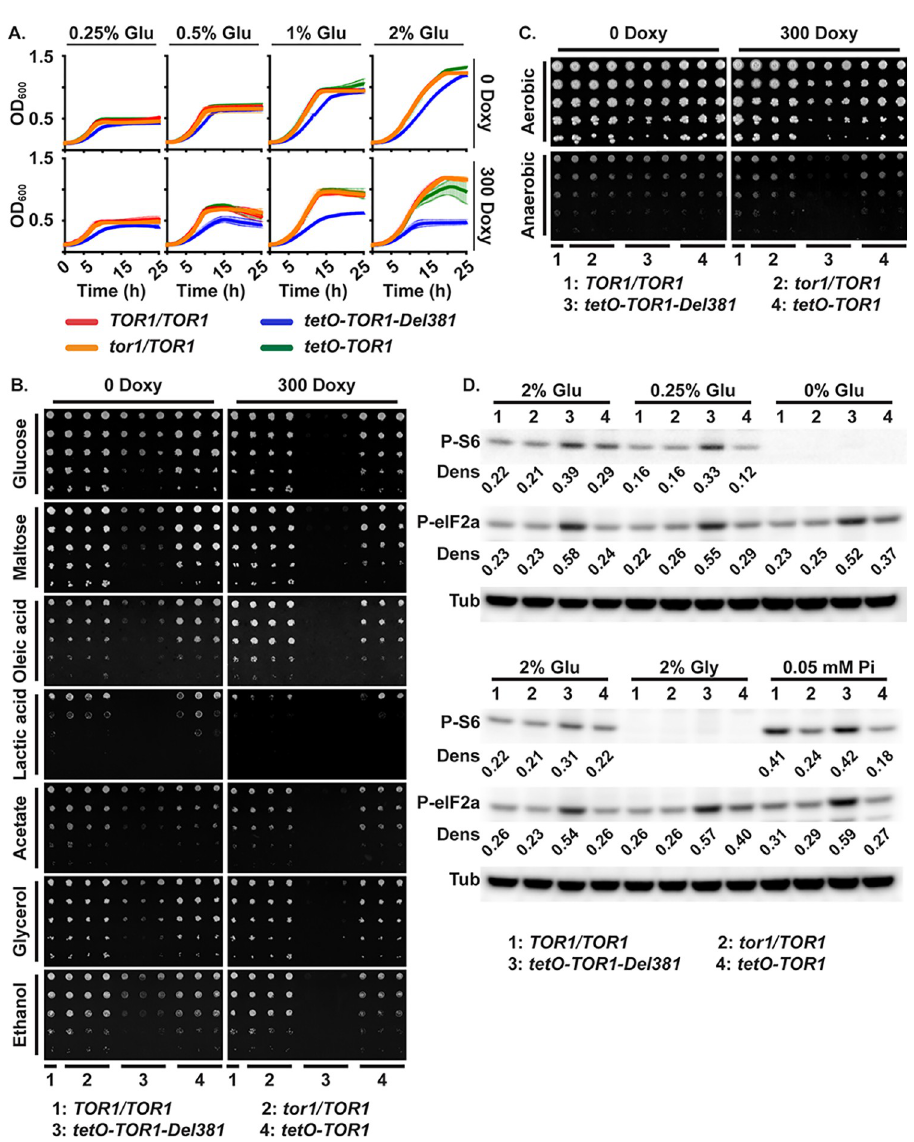
Fig 3. Cells lacking Tor1 N-terminal HEAT repeats failed to adapt growth to carbon source availability and were defective in growth on non-fermentable carbon sources. A. Cells were grown in YNB medium with varying concentration of glucose (Glu), without or with 300 ng/ml doxycycline (300 Doxy). B. Cells of indicated genotypes were spotted onto YNB without inositol agar medium containing different carbon sources (2% w/v), without or with 300 ng/ml doxycycline. ( TOR1/TOR1 , JKC1713; tor1/TOR1 , JKC1345, JKC1346, JKC1347; tetO-TOR1 - Del381 , JKC1442, JKC1445, JKC1441; tetO-TOR1 , JKC1543, JKC1546, JKC1549). C. Cells of indicated genotypes were spotted onto YPD agar medium without or with 300 ng/ml doxycycline and incubated either aerobically or anaerobically for 48 h. D. Western blot. Cells pre-grown in YPD with 5 ng/ml doxycycline for 4 h were inoculated into YNB with 5 ng/ ml doxycycline containing final nutrient concentrations as indicated (2% Glu: 2% glucose, 10 mM Pi; 0.25% Glu: 0.25% glucose, 10 mM Pi; 0% Glu: no added direct carbon source, 10 mM Pi; 2% Gly: 2% glycerol, 10 mM Pi; 0.05 mM Pi: 2% glucose, 0.05 mM Pi). Protein extracts were probed with antibody to phosphorylated Rps6 (P-S6) or phosphorylated eukaryotic translation initiation factor 2A (P-eIF2a), and tubulin (Tub) as loading control. Dens: signal intensity ratio of P-S6 or P-eIF2a to Tub. ( TOR1/TOR1 , JKC1713; tor1/TOR1 , JKC1346; tetO-TOR1-Del381 , JKC1445; tetO-TOR1 , JKC1546). Same Western blotting membranes were sequentially probed with P-S6 antibody and then P-eIF2a